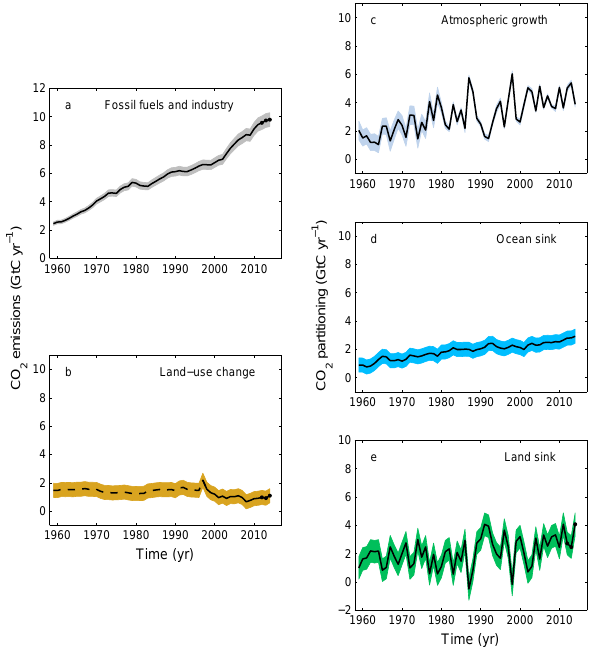
Figure 4. Components of the global carbon budget and their uncer- tainties as a function of time, presented individually for (a) emis- sions from fossil fuels and industry ( E FF ), (b) emissions from land- use change ( E LUC ), (c) atmospheric CO 2 growth rate ( G ATM ), (d) the ocean CO 2 sink ( S OCEAN ; positive indicates a flux from the atmosphere to the ocean), and (e) the land CO 2 sink ( S LAND ; pos- itive indicates a flux from the atmosphere to the land). All time se- ries are in GtCyr − 1 with the uncertainty bounds representing ± 1 σ in shaded colour. Data sources are as in Fig. 3. The black dots in panels (a) , (b) , and (e) show preliminary values for 2012, 2013, and 2014 that originate from a different data set to the remainder of the data, as explained in the